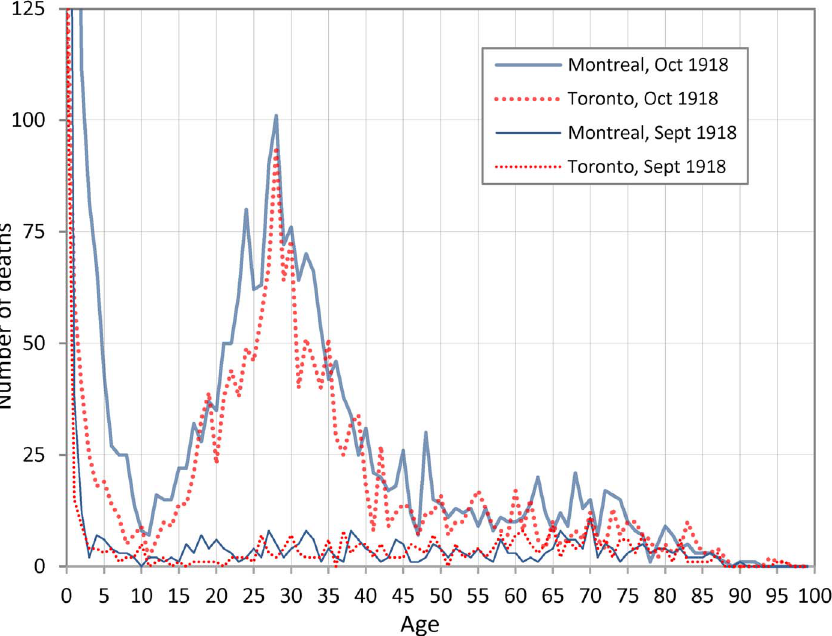
Figure 1. Recorded deaths (from all causes) by age in Montreal and Toronto, September and October, 1918. doi:10.1371/journal.pone.0069586.g001 PLOS ONE |